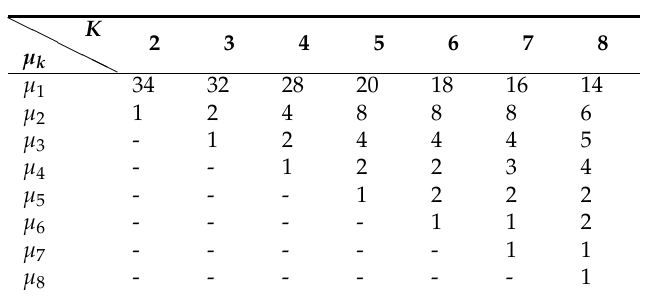
Table 2. Service rates µ k , k = 1, . . . , K .